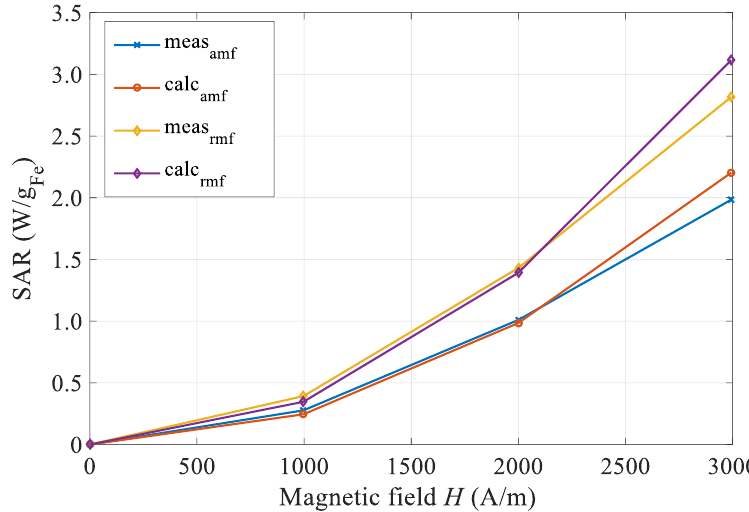
Figure 9. Comparison of measured and calculated SAR curves for alternating and rotating magnetic field at 402 kHz.